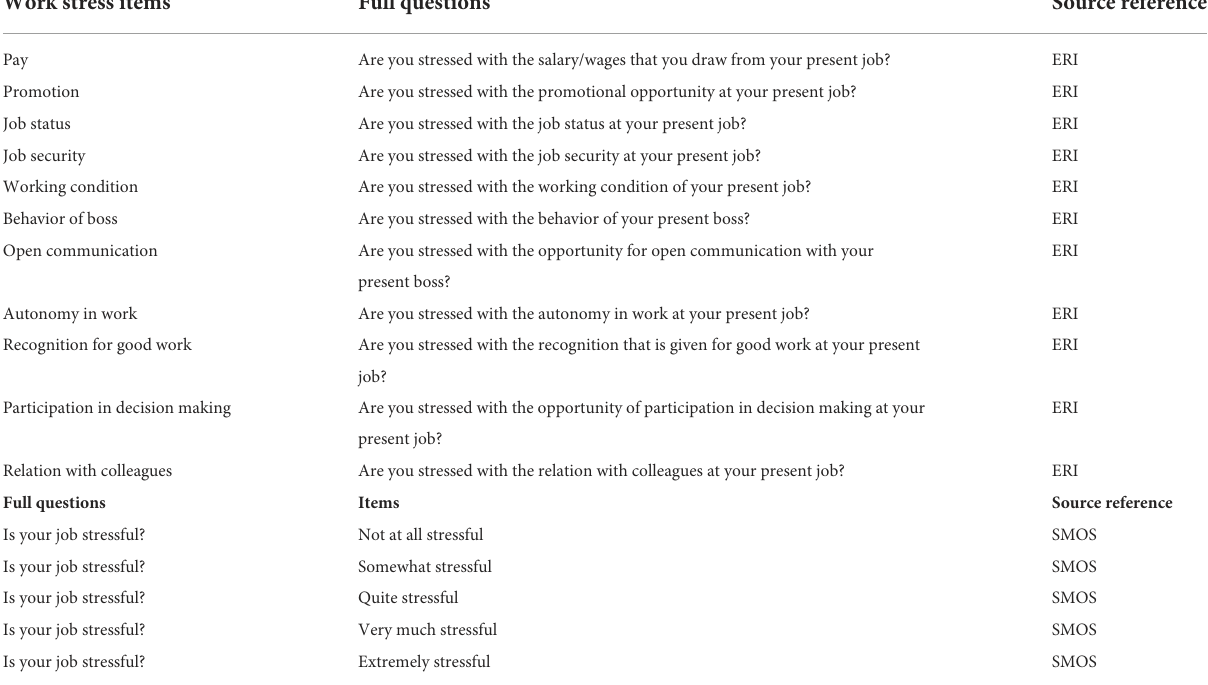
TABLE 1 Overview of the work stress items Modified ERI and SMOS.